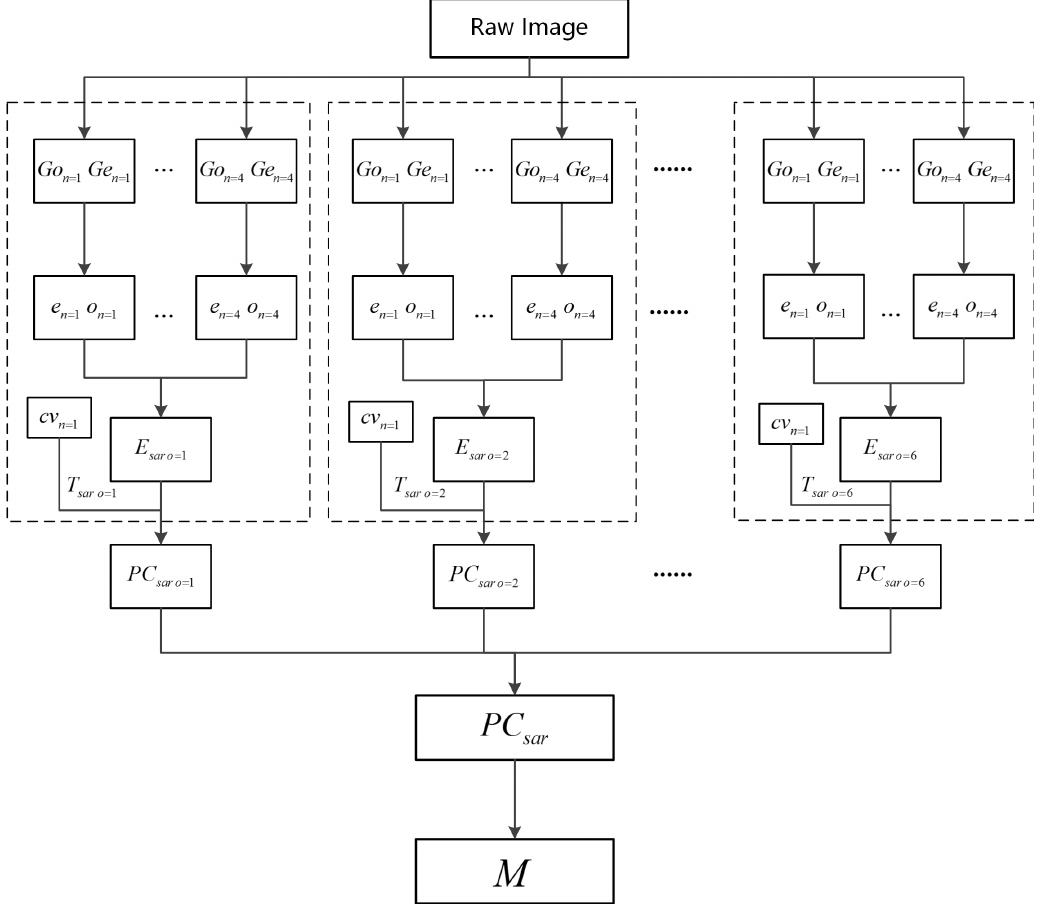
Figure 3. Flow chart of the Synthetic Aperture Radar Phase Congruency detector